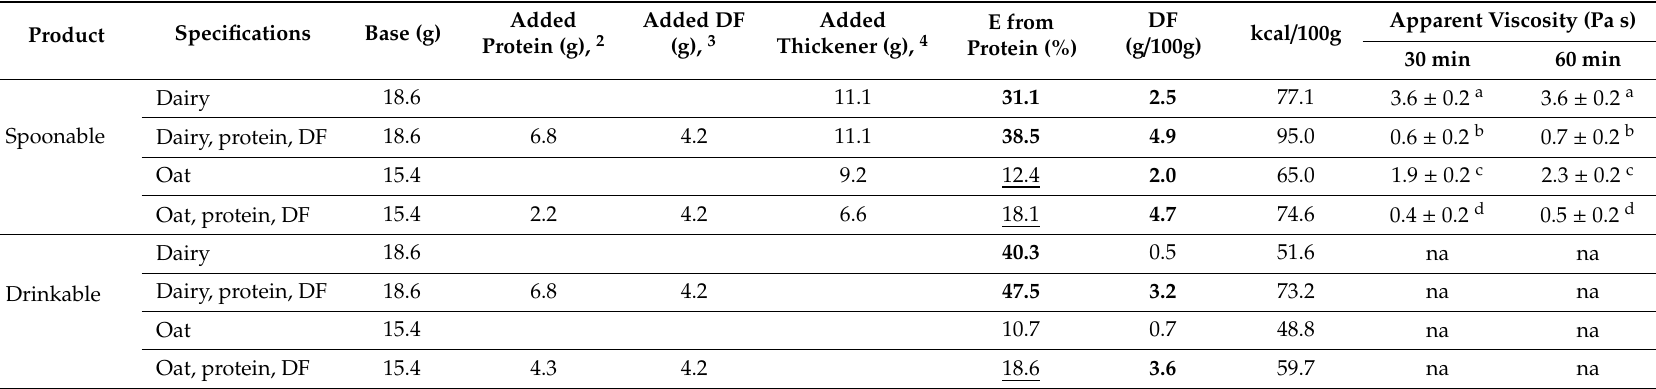
Table 1. Recipes, nutritional information, and viscosity of cocoa spoonable and drinkable snacks used in sensory profiling and consumer trials. Water content in all samples is 100 mL. Mean values ± standard error followed by a di ff erent letter indicate statistically significant di ff erences between samples at p < 0.05 (Tukey’s honest significant di ff erence). Those that qualify for ’source of protein’ and ’source of fiber’ nutrition claims are underlined, and those ’high in protein’ or ’high in fiber’ are in bold 1 . DF = dietary fiber, E = energy, na = not